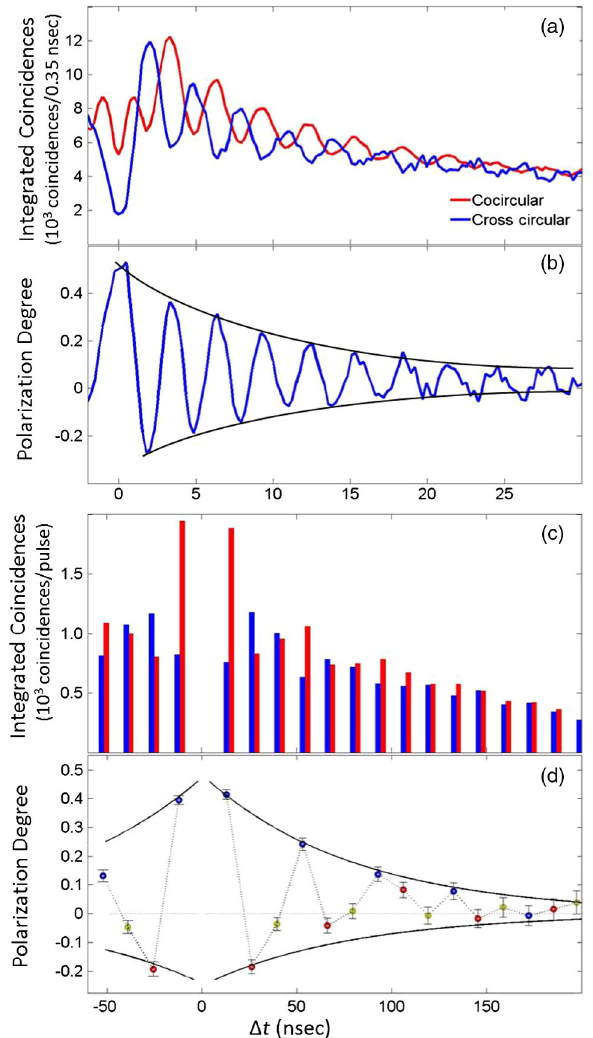
FIG. 5. (a) Polarization-sensitive intensity autocorrelation mea- surements of the XX 0 biexciton (vertical magenta arrow in T (cid:1) 3 Fig. 1) under resonant cw excitation (vertical green arrow in Fig. 1). The red (blue) lines display the cocircular (cross-circular) coincidence measurements. (b) The degree of circular polariza- tion of the second detected photon as a function of its detection time as deduced from the measurements in (a). The decay of the polarization oscillations is overlaid by an exponential decay curve (solid black line) with characteristic time of ∼ 25 nsec. (c) Similar to (a) but under pulsed excitation at a repetition rate of 76 MHz. The red (blue) bars display the integrated number of coincidences emitted after each laser pulse for cocircularly (cross-circularly) polarized photons. (d) Like (b) but for the pulsed excitation presented in (c). From the temporal decay of the amplitude of the oscillations (solid black lines), a lower bound of 100 (cid:1) 20 nsec for the DE coherence time is